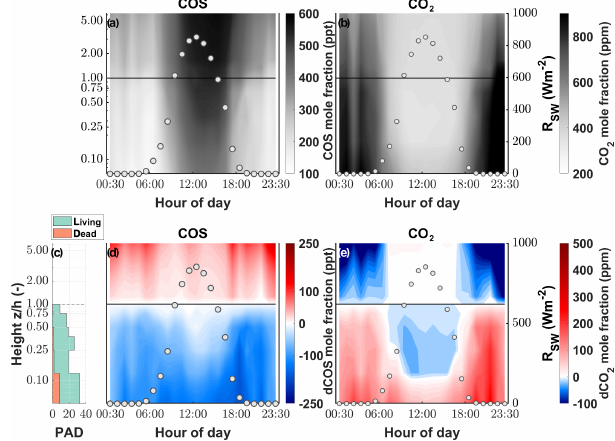
Figure 3. Vertical gradient of the (a) COS and (b) CO 2 mole frac- tion (parts per trillion and parts per million, respectively) depicted by the background color between the soil and the eddy covariance tower at 250cm for 1d. The left y axis shows the log of the mea- surement divided by the canopy height ( z/h ). The white circles de- pict the incoming shortwave radiation ( R SW ; Wm − 2 ). Plant area density (PAD) split into living (green) and dead (orange) plant ma- terial (c) . Vertical gradient of the difference between the mole frac- tion at canopy height and each measurement height for (d) COS and (e) CO 2